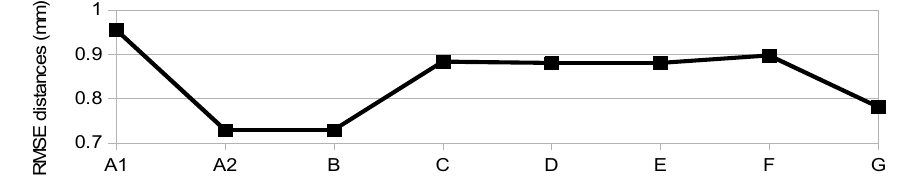
Figure 4. Root Mean Squared Error (RMSE) of the check distances.